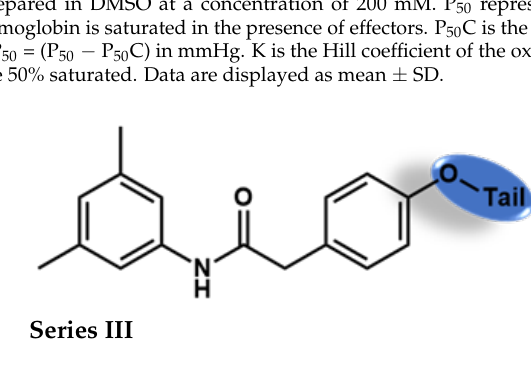
Series IV Table 4. Results of in vitro red blood cell studies.